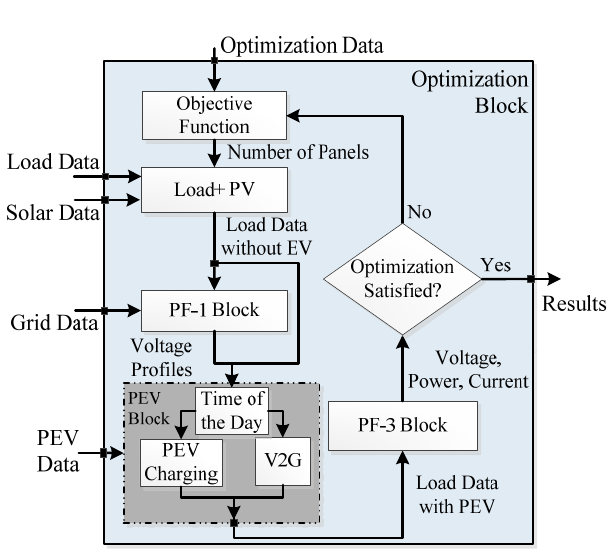
Figure 2. Proposed optimization method.